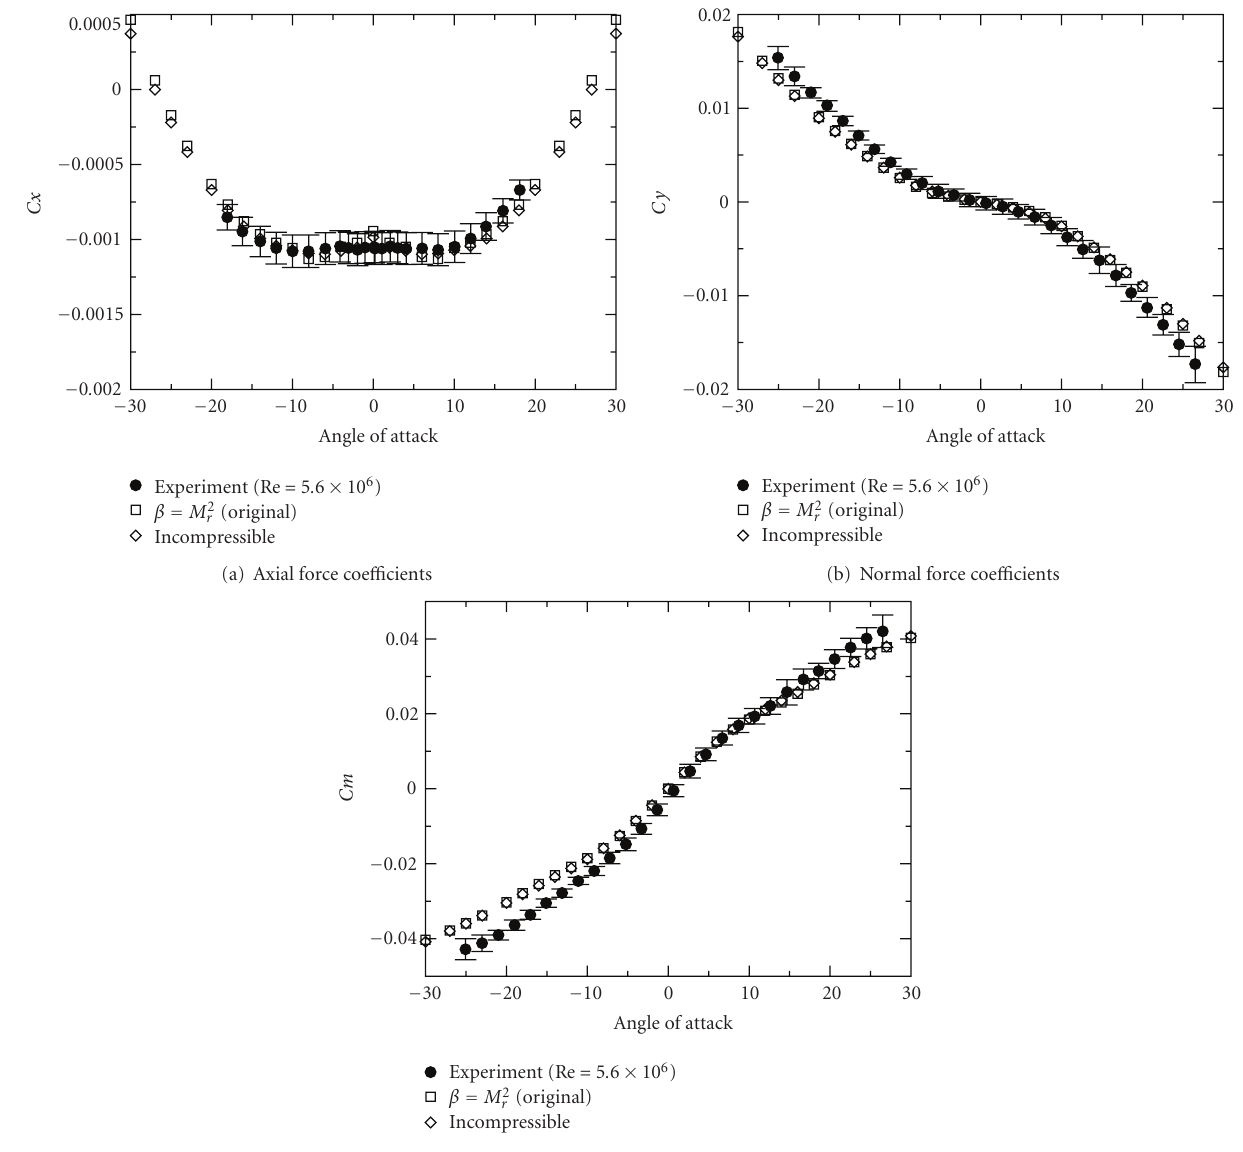
Figure 7: Comparison of predicted and measured force and moment coe ffi